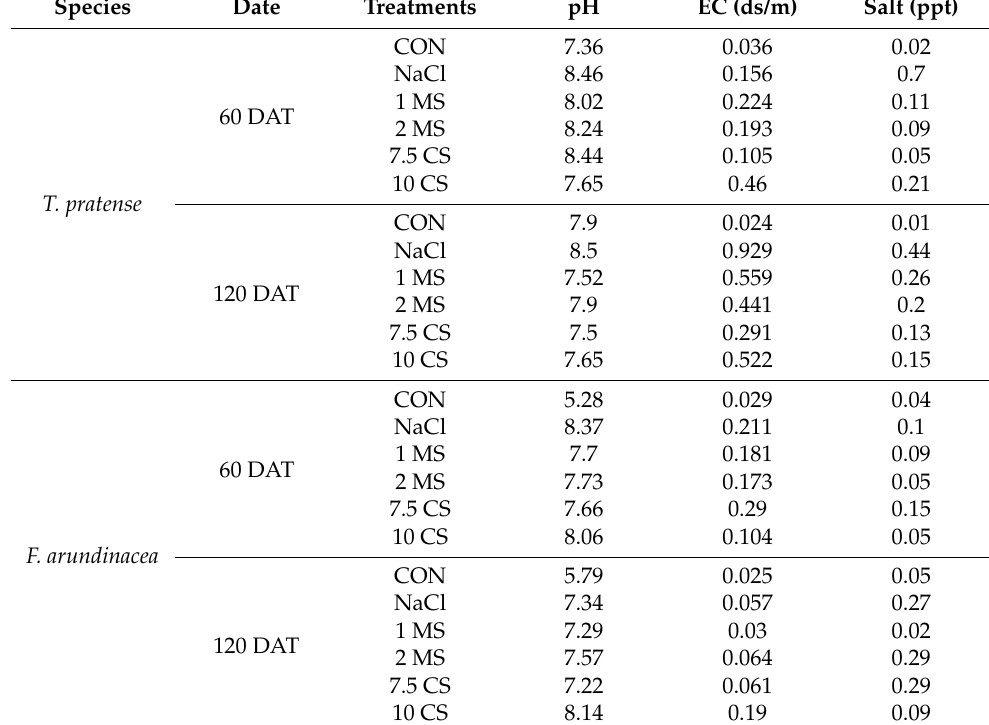
Table 3. Soil pH, electrical conductivity (EC), and salt values with six different treatments. Species